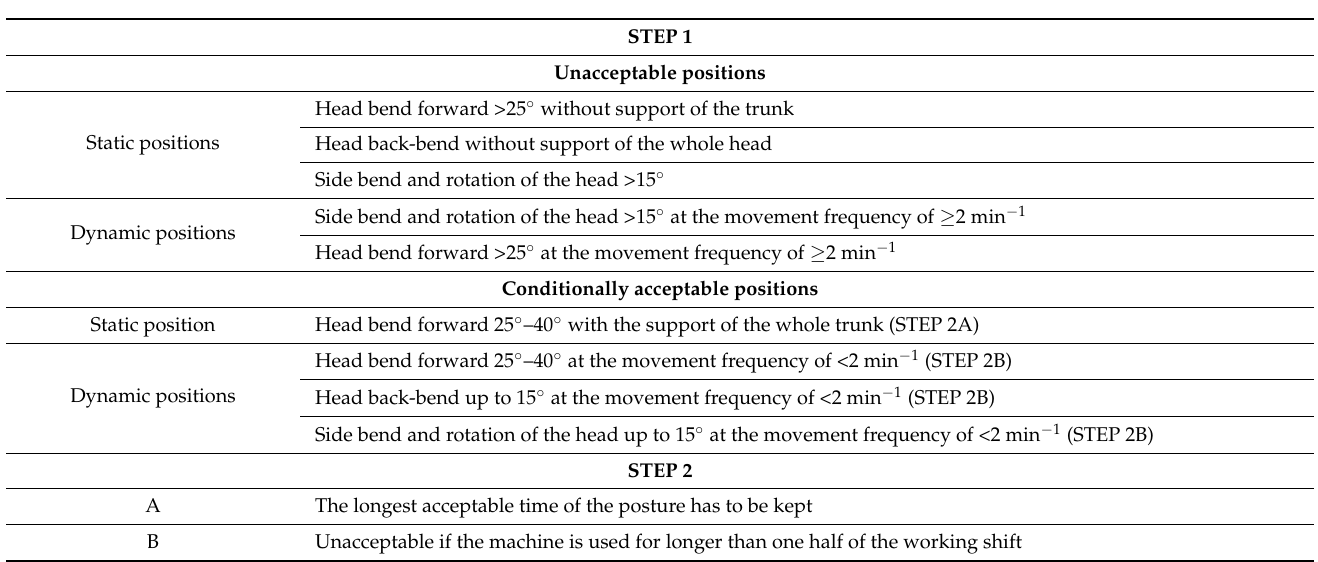
Table 6. Positions of head and neck